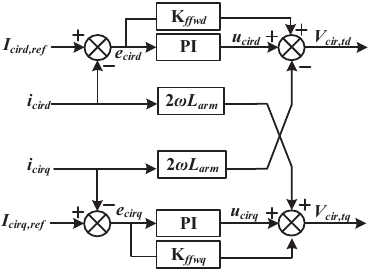
Figure 4. Block diagram of the circulating current control designed in dq -frame.